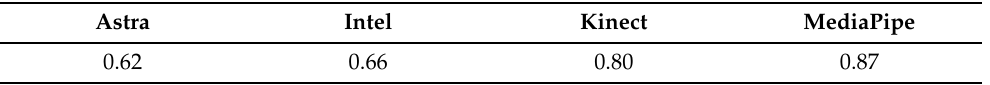
Table 6. Pearson correlation of sensors for all data to LL data; blue (>0.75 and < 0.9) and yellow (>0.5 and < 0.75). Astra Intel Kinect